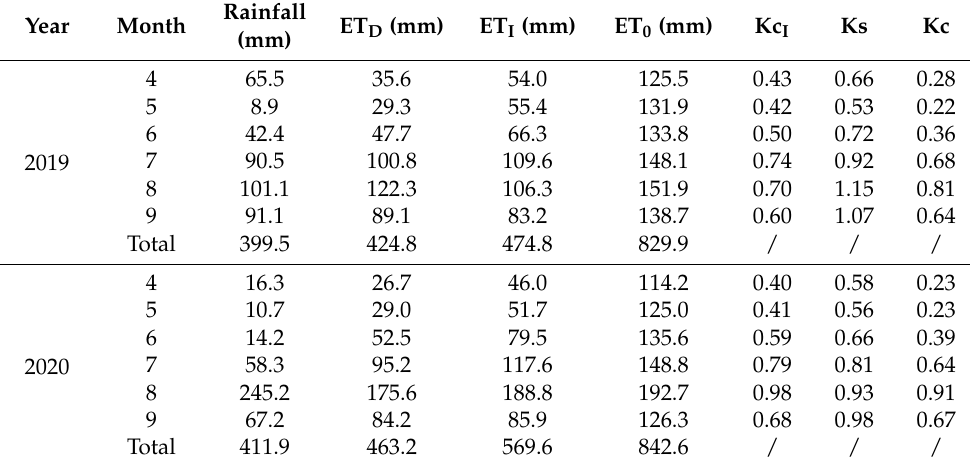
Table 4. Variation of crop coefficient Kc under different soil